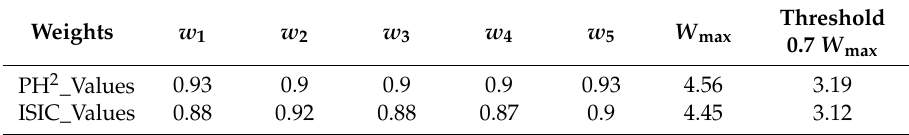
Table 4. Establishing the weights of the individual classifiers and decision threshold.